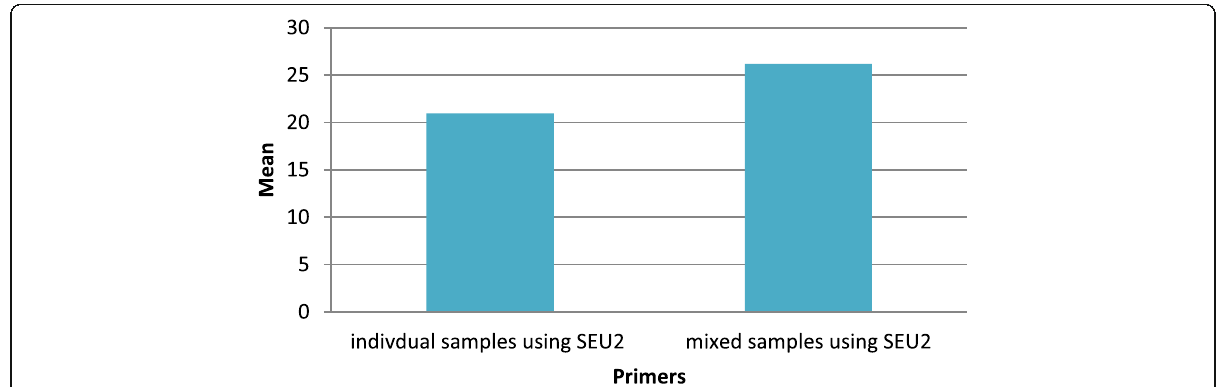
Fig. 5 Comparison between Cq values of SEU2 amplification in individual semen samples and mixed body